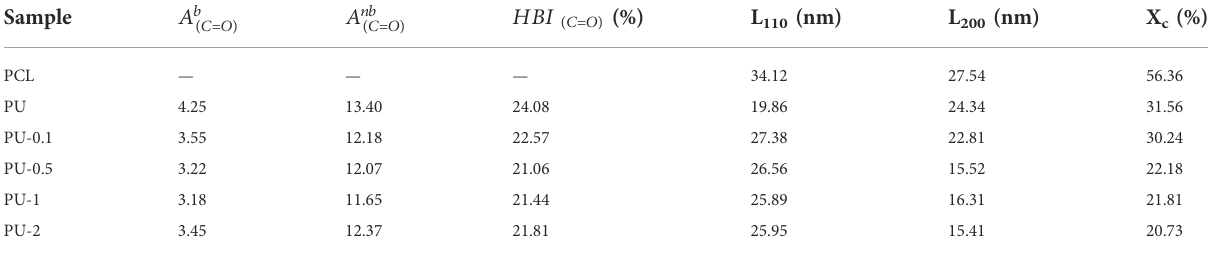
TABLE1ThehydrogenbondingindexesHBI (C=O) ,crystalsizesofplanes(110)and(200)(L 110 andL 200 ),andcrystallinitycontents[Xc(%)]ofPCL,SMPU, and SMPU/i-MWCNT composites with various i-MWCNT contents. Sample